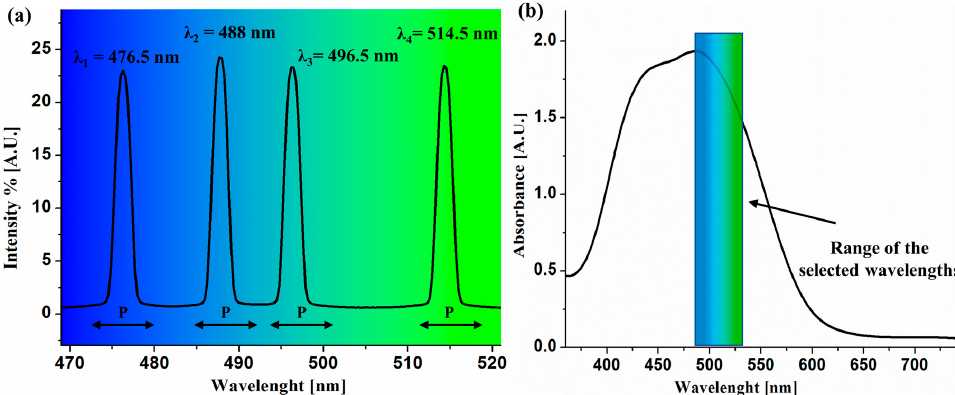
Figure 1. ( a ) Spectral composition (intensity and polarization state) of the multi-wavelength recording beams. ( b ) Absorption spectrum of the PDR1Ma thin film overlaid with the used wavelength range. A top view scheme of the experimental setup used to generate the light pattern is shown in Figure 2. Since λ 1 and λ 4 are initially much more intense compared to the other two wavelengths, the Ar+ laser beam is directed through a filter (composed of a half wave plate and a polarizer, P1, with the optical axis oriented in the vertical y-direction) with the aim to equalize the intensity values of the four lines. To ensure efficient SRG formation, the outcome polarization is then rotated along the horizontal x-direction [19], p-polarization, combing a broadband quarter wave plate and a second polarizer, P2.